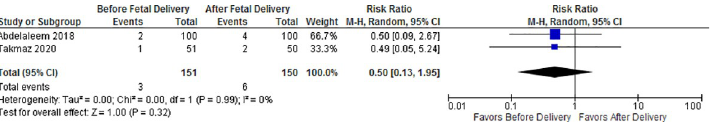
Fig 5. Forest plot of oxytocin given before versus after fetal delivery. Outcome: incidence of blood transfusion.